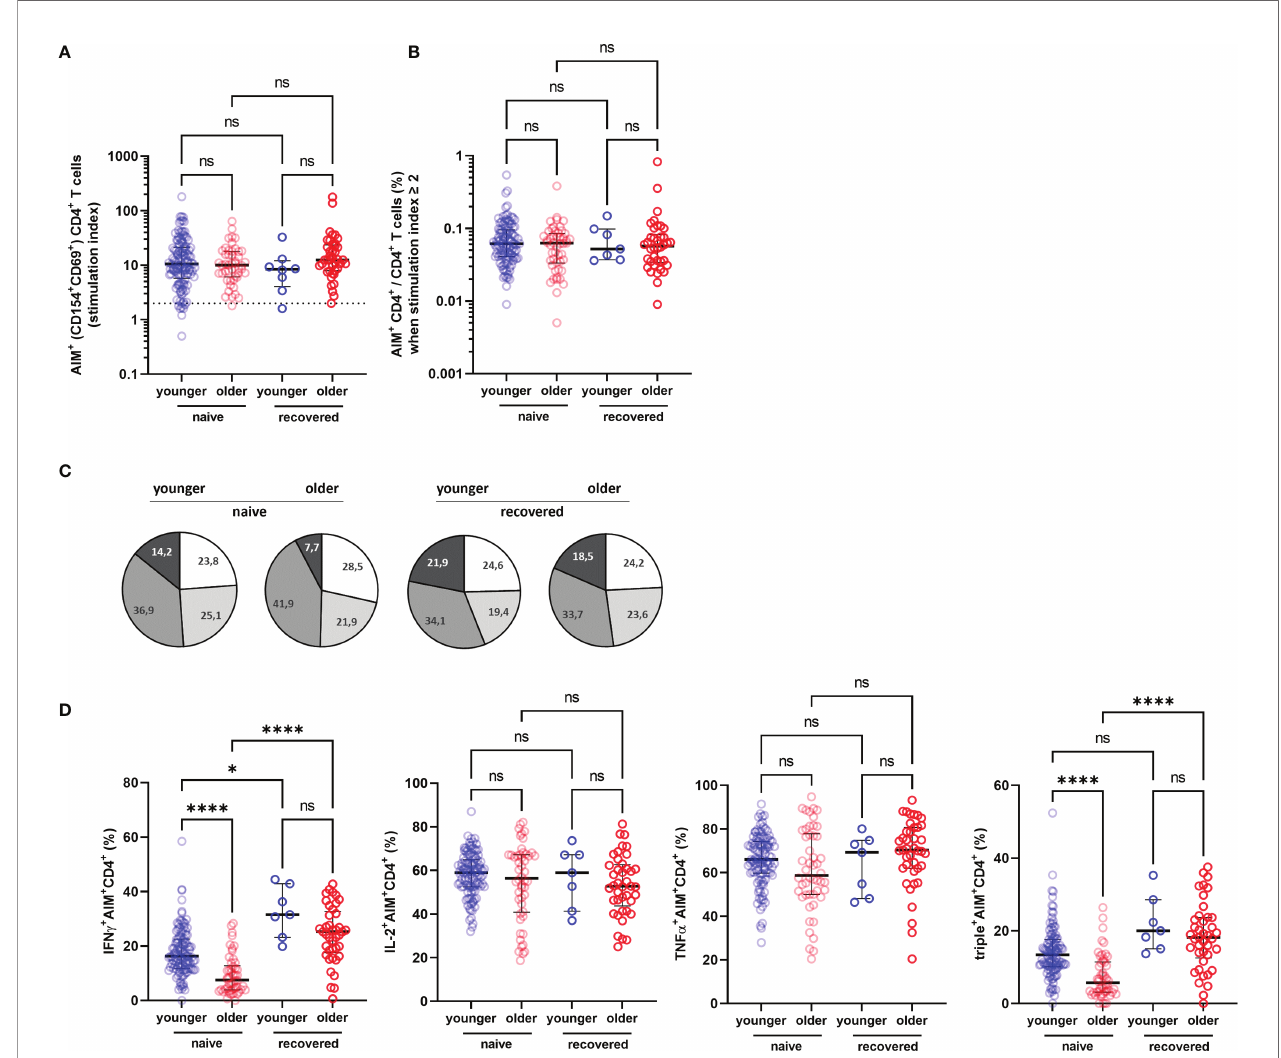
FIGURE 5 | Speci fi c CD4 + T-cell response in older and in young adults 3 months after the fi rst injection of BNT162b2. (A) Speci fi c CD4 + T cells according to activation-induced markers (AIM), reported with their stimulation index. (B) Percentage of AIM + CD4 + T cells among total CD4 + T cells in responders, i.e., participants with a stimulation index ≥ 2. (C) Pie charts representing the relative proportions of AIM + CD4 + T cells producing none (white), one (light grey), two (medium grey), or three cytokines (dark grey) out of INF g , IL-2, and TNF a according to participant group and past history of COVID-19 (naive and recovered). (D) Proportion of AIM + CD4 + cells producing IFN g , IL-2, TNF a , and proportion of IFN g + IL-2 + TNF a + (triple + ) CD4 + T cells according to participant group and past history of COVID-19 (naive and recovered). (COVID-19-naive young adults n = 113, COVID-19-naive older n = 48, COVID-19-recovered young n = 8, COVID-19-recovered older n = 41; median [interquartile range (IQR)] are shown). * p -values < 0.05; **** p -values < 0.0001; ns, not signi fi cant. AIM + , cell-expressing activation-induced